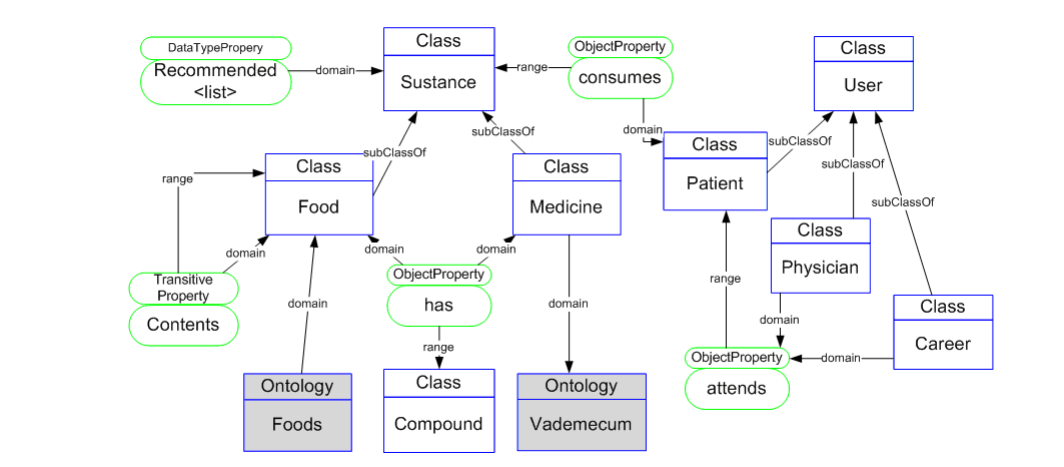
Figure 3. Ontological concepts and properties involved in the example of axiomatic